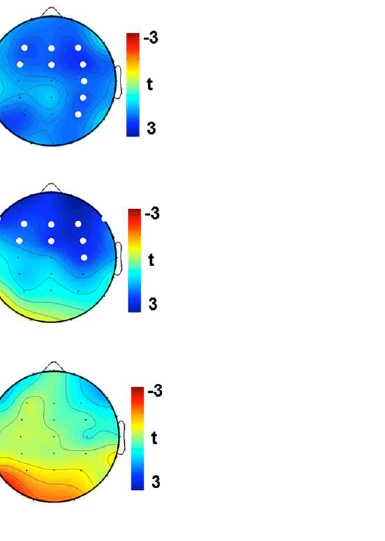
Fig 4. Event Related Potentials of the pre-stimulus activity are representedon the left side of the figure. The time windowsof analysesare highlighted.The topographicaldistributions of t-values are represented on right side of the figure. The white dots are the electrodes where the statistically significant differences are expressed.4a) ‘Crash End’ and ‘No Crash End’,4b) ‘No Crash Baseline’and ‘No Crash End’, 4c) ‘No Crash Baseline”and ‘Crash End’.